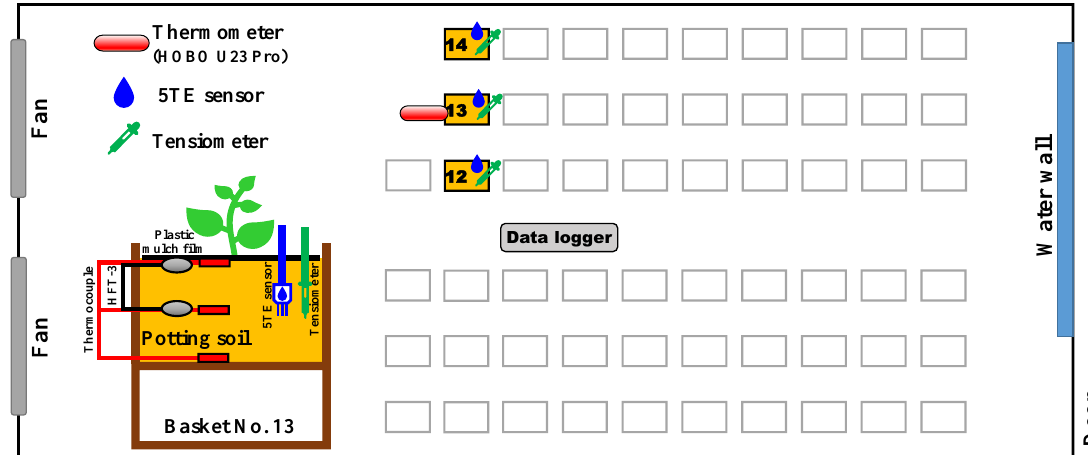
Figure 1. Experimental instrument diagram of the greenhouse. The long-term cherry tomatoes experiment was performed in baskets No. 12, No. 13, and No.14.